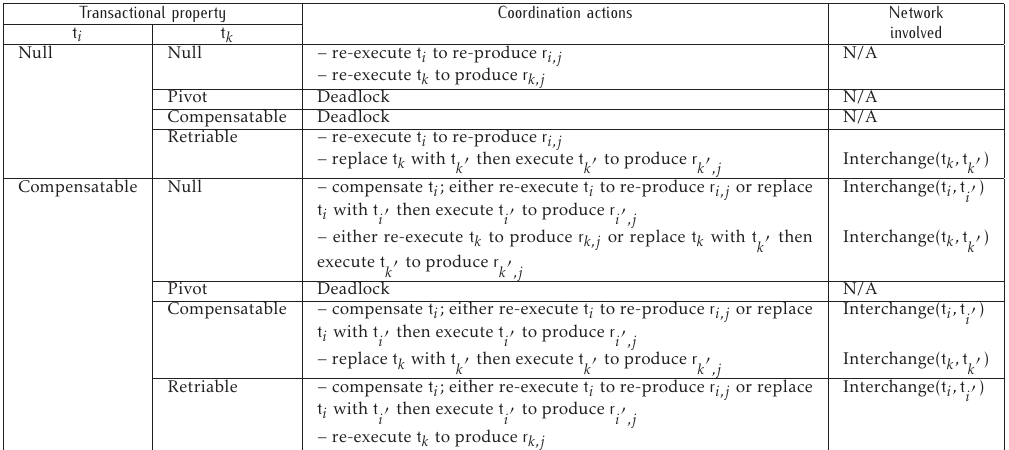
/limited property/case 1